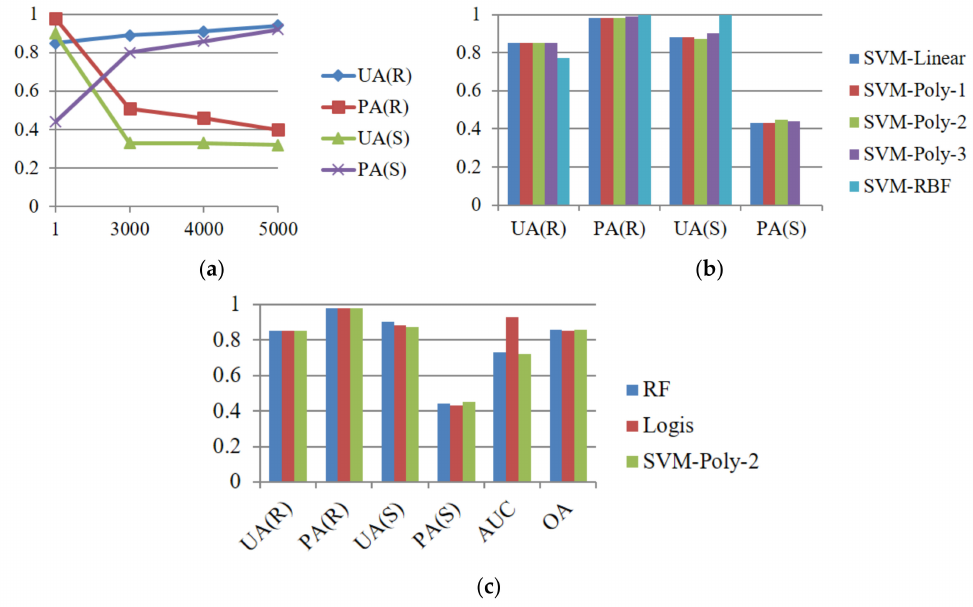
Figure 9. Performance ( Y -axis) of the No. 2 model, where OA, AUC, PA, UA, S, and R represent the overall accuracy, area under the ROC curve, producer’s accuracy, user’s accuracy, landslide source, and runout, respectively. ( a ) Using the RF algorithm with the costs; ( b ) using SVM with linear, the first- to third-order polynomial, and radial basis (RBF) functions; ( c ) comparing the optimal results of ( a ) and ( b ) by using logistic (Logis) regression.